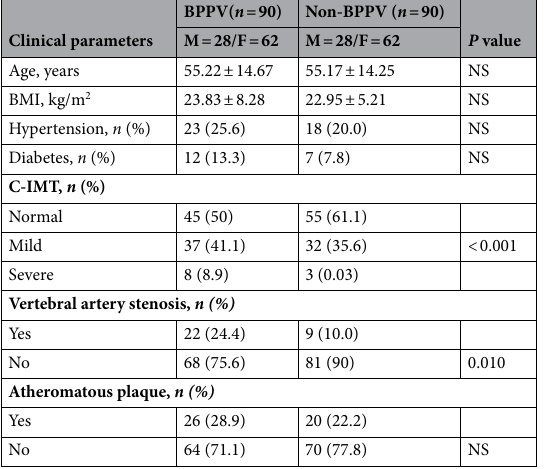
Table 1. Comparison of clinical parameters between the BPPV and control groups. Normal, ≤ 0.1 cm; mild, 0.1–0.13 cm; and severe ≥ 0.13 cm. BMI body mass index, BPPV benign paroxysmal positional vertigo, C-IMT carotid intima-media thickness, NS not significant.